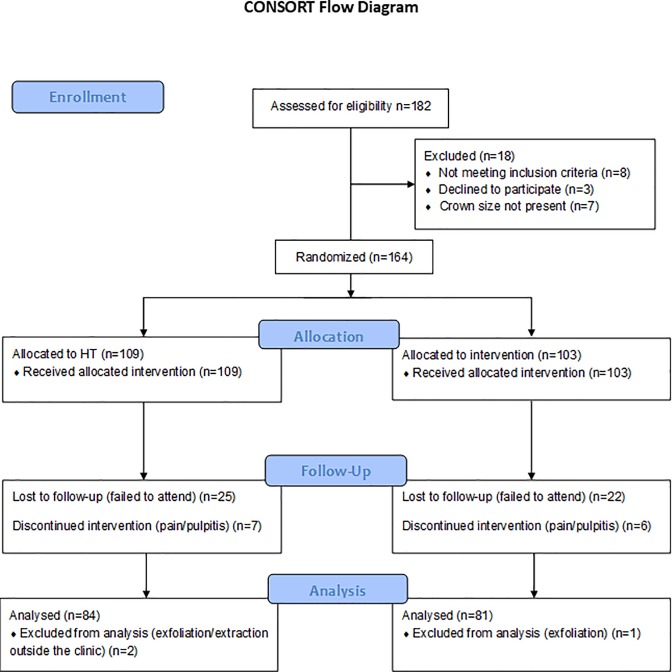
CONSORT flow diagram.